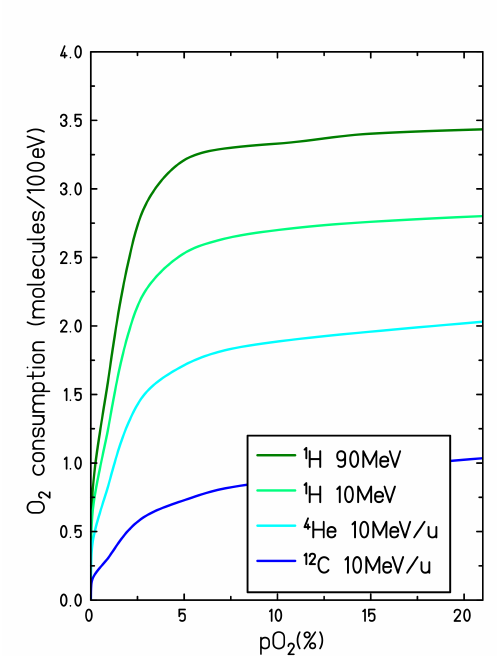
Figure 5. Consumption of the molecular oxygen for different target oxygenation levels and induced by different LET radiations. The consumption yields are calculated at the end of the chemical track evolution, t = 1 µ